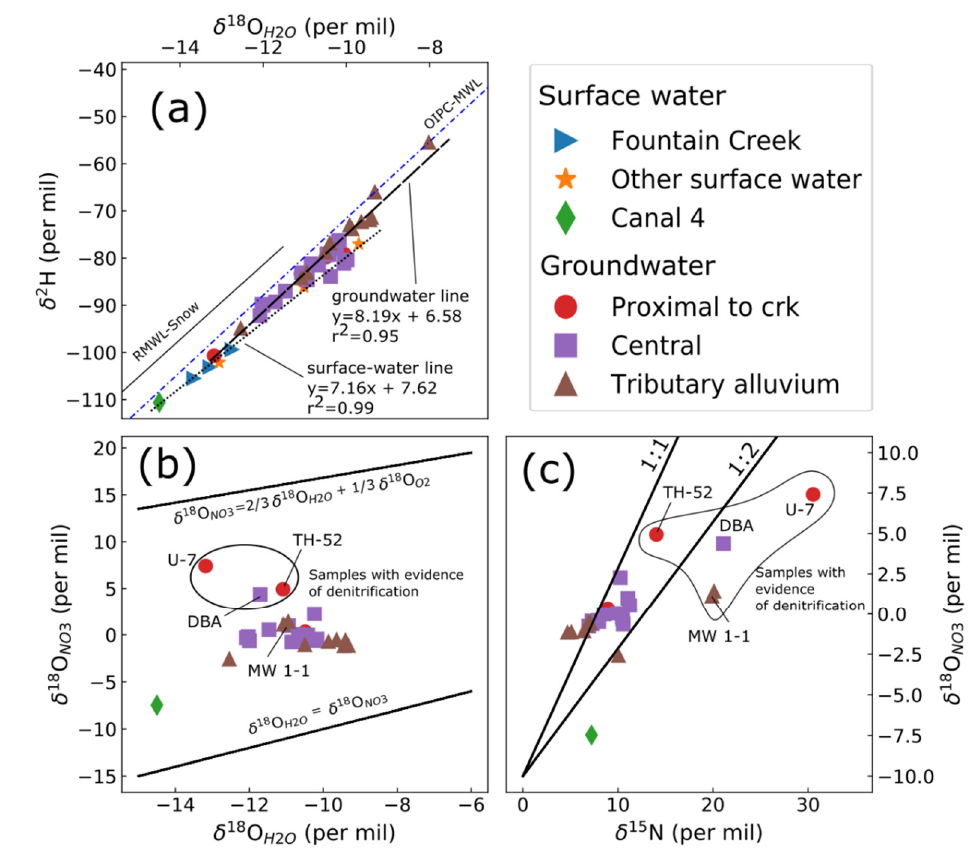
Figure 2. ( a ) Stable-isotopic composition and regression lines for groundwater and surface-water samples (snowpack-driven Rocky Mountain Meteoric Water Line (RMWL-Snow) from Reference [78] and isotopes in precipitation calculator (OIPC) meteoric water line (MWL) from Reference [79]), ( b ) δ 18 O H2O vs. δ 18 O NO3 with specific wells labeled with site alias and lines representing theoretical sources of oxygen during denitrification reactions [41,82], and ( c ) δ 15 N vs. δ 18 O NO3 with specific wells labeled with site alias and lines for ranges of fractionation trends applicable to nitrate reduction [82].